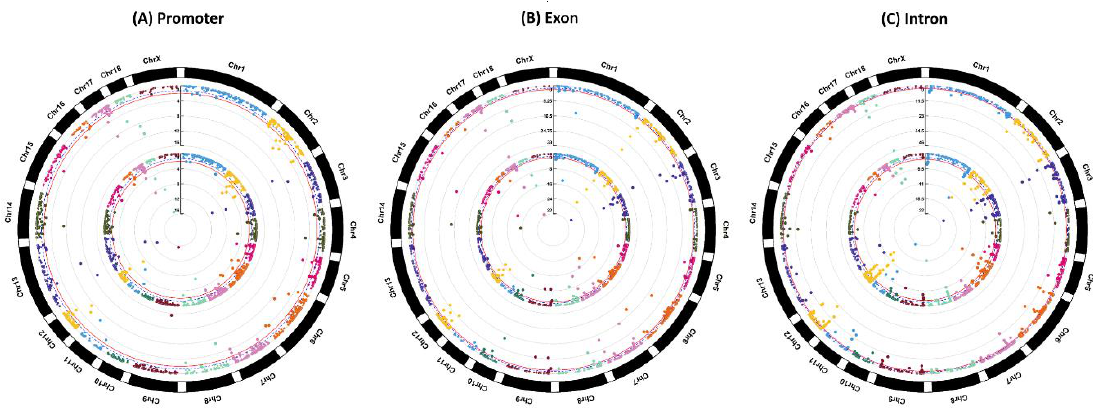
Figure 4. Manhattan plots of genome-wide DNA methylation for BT. Note: Plots from outside track to inside track indicate the Q -values of ( A ) promoters, ( B ) exons and ( C ) introns and the Q -values of ( A ) promoters, ( B ) exons and ( C ) introns overlapped with CpG islands, respectively. Blue dotted and red solid lines indicate the Q -value threshold of 0.05 and 0.01, respectively.